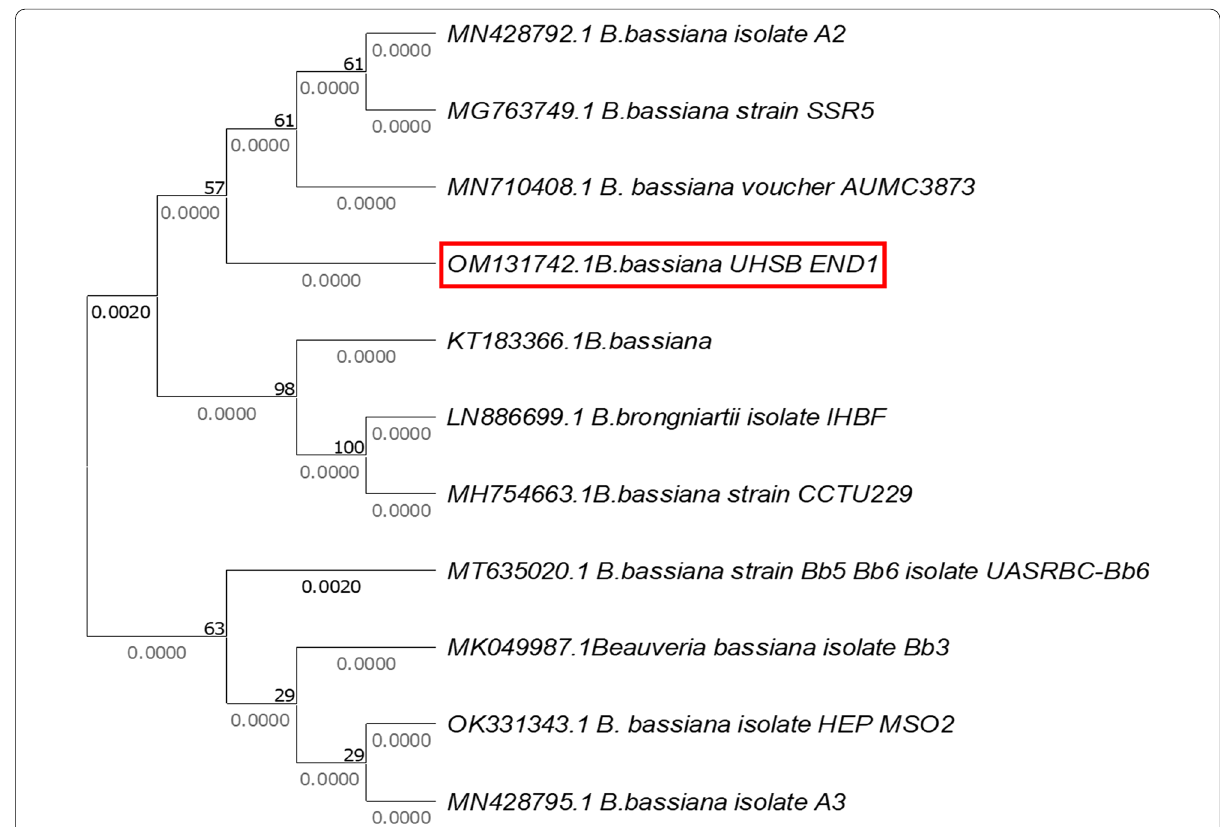
Fig. 2 Phylogenetic tree based on Neighborhood Joining (NJ) analysis. The sequence OM131741 is the sequence generated in the present study of Beauveria bassiana UHSB-END1, and it is branched with retrieved sequences of B.